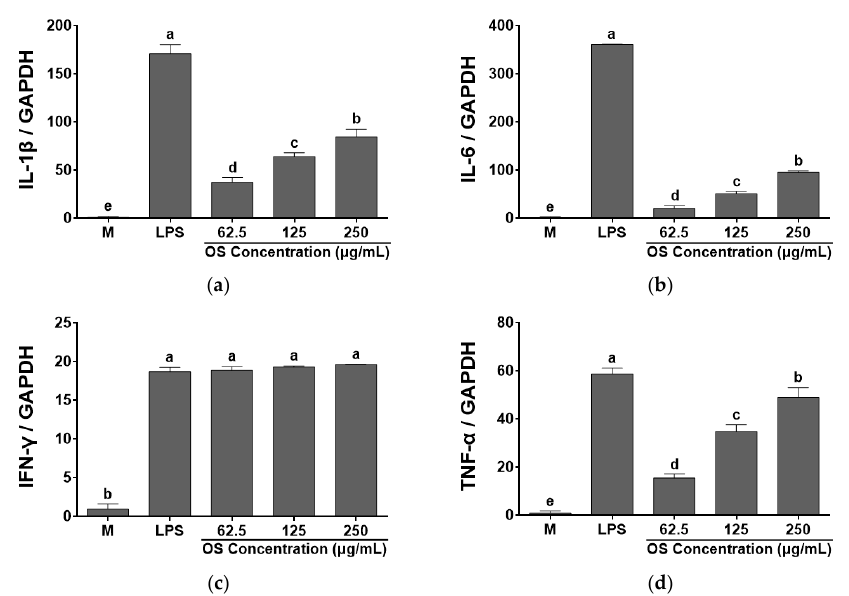
Figure 6. Effects of A. cepa skin (OS) extracts on the expressions of ( a ) IL-1 β , ( b ) IL-6, ( c ) IFN- γ , and ( d ) TNF- α by RAW 264.7 cells. Data was expressed as the mean ± SEM. a–e Different letters are significantly different at p < 0.05.